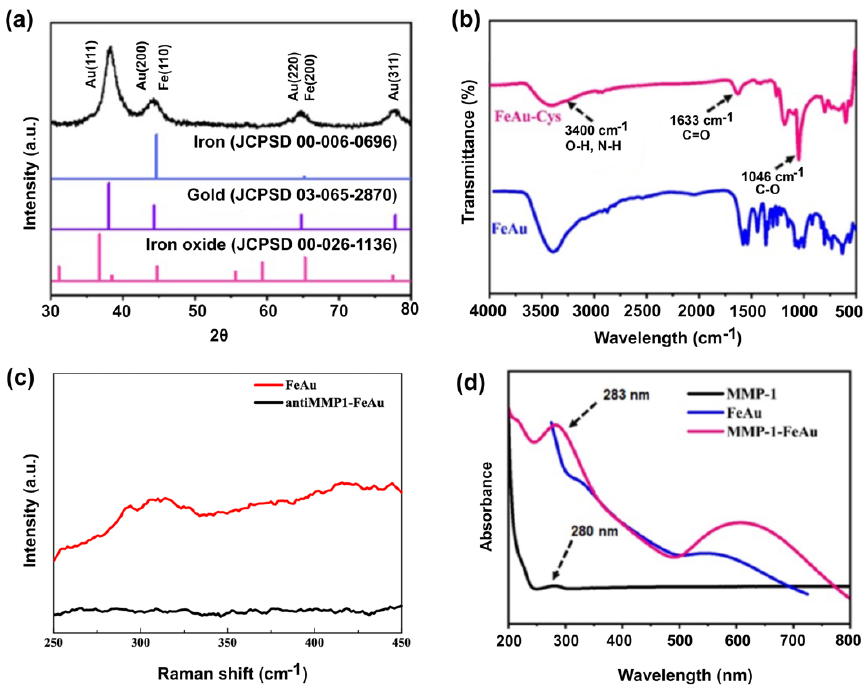
Figure 2. Confirmation of MMP-1 conjugation to FeAu nanoparticles. ( a ) X-ray diffraction pattern of FeAu NPs, ( b ) FTIR pattern of FeAu and FeAu-Cys, ( c ) Raman spectra before and after FeAu NPs modification, and ( d ) UV-Vis spectrum of FeAu NPs before and after MMP-1 antibody modification. Table 1. Elemental distribution analysis using EDS.